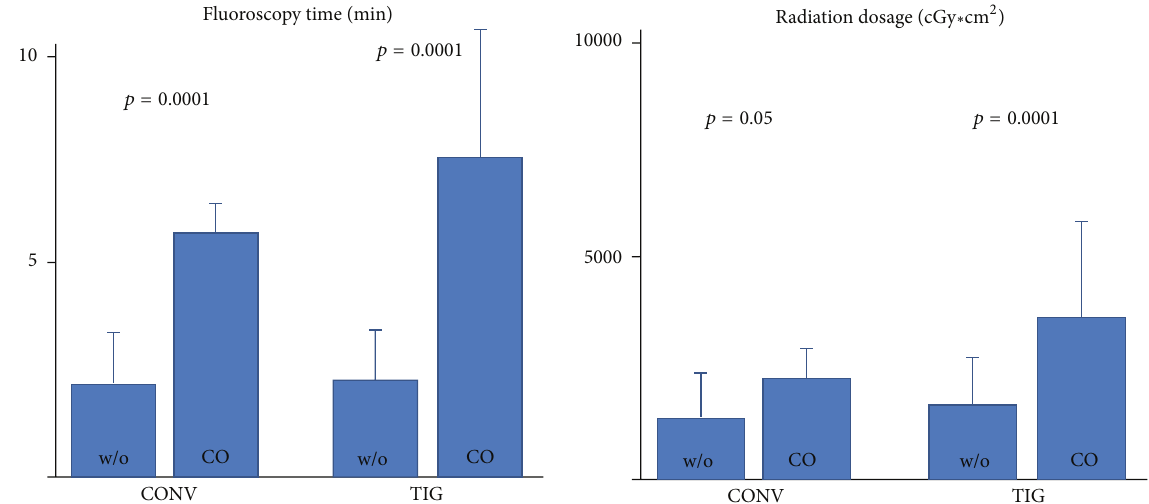
Figure 3: Fluoroscopy time and radiation dosage in conventional catheters versus radial catheters.